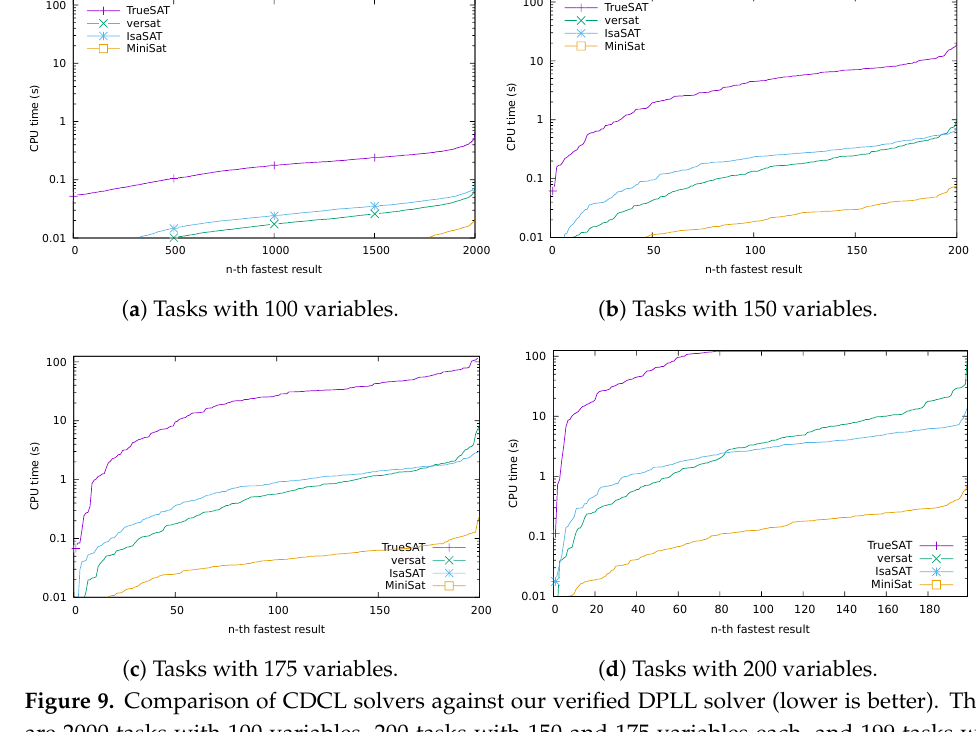
Figure 9. Comparison of CDCL solvers against our verified DPLL solver (lower is better). There are 2000 tasks with 100 variables, 200 tasks with 150 and 175 variables each, and 199 tasks with 200 variables. We plot the running time taken by the n-th fastest result for each solver. The running time of any solver on any given task is capped at 120 s. The y axis uses a logarithmic scale. The IsaSAT solver and TrueSAT are verified, while MiniSAT is